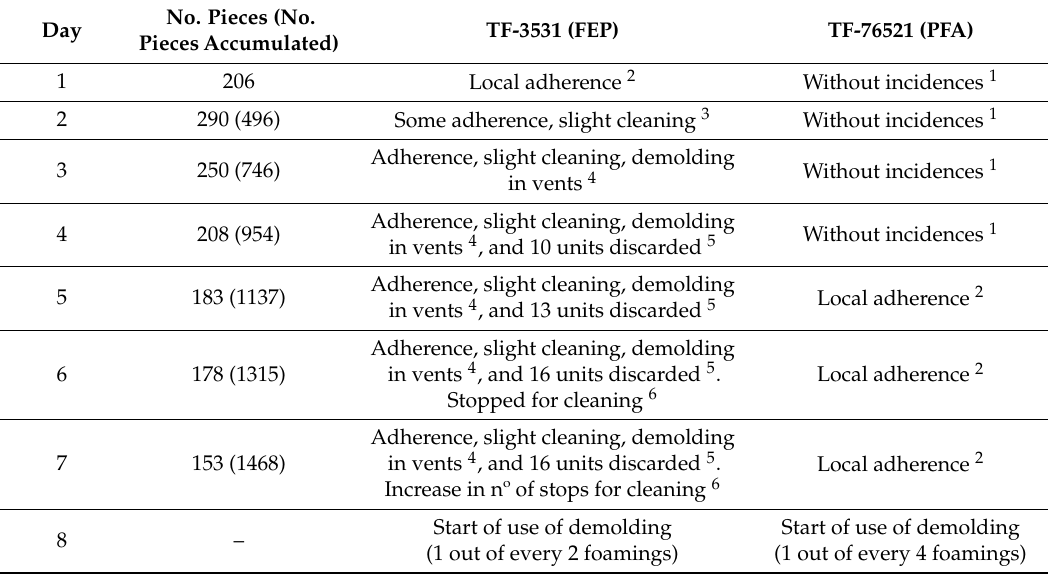
Table 3. Results of the industrial test of pieces of PUR foam in a mold of aluminium with two tracks, so that in one, the FEP-type coating was applied, and in the other, PFA was applied.